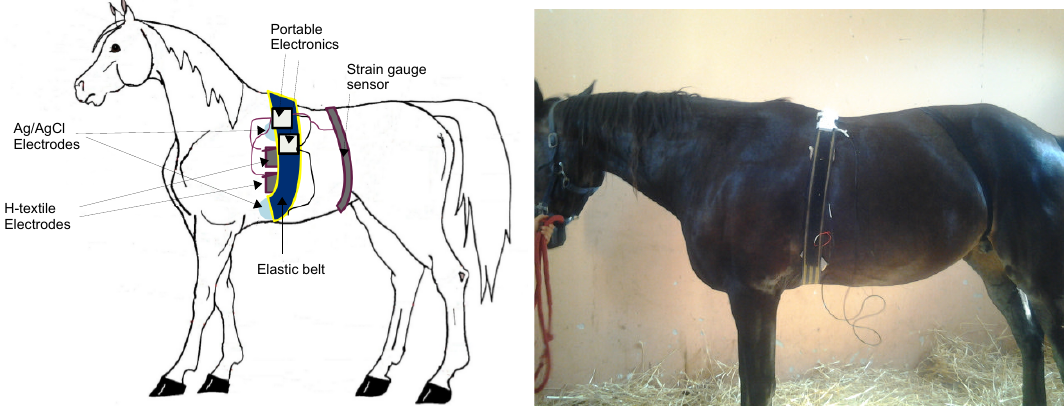
Figure 2. Systems placement on the horse. Elastic smart belt and Ag/AgCl electrodes placement. A scheme is presented on the left side and a real picture is on the right